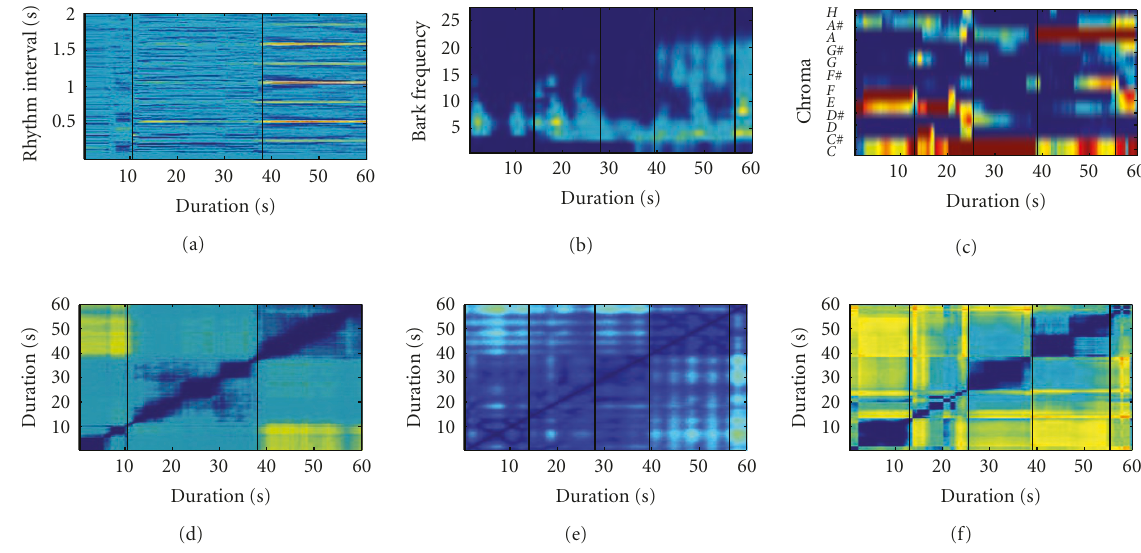
Figure 7: Rhythm, timbre and chroma of The Marriage . Feature (top) and self-similarity (bottom). The automatic segmentation points are marked with vertical solid lines.